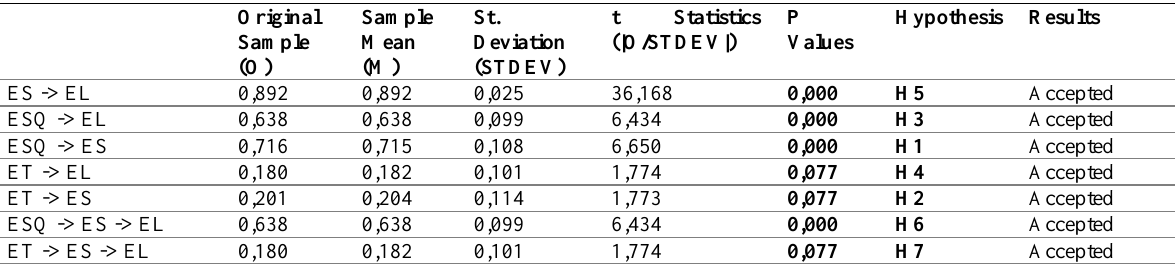
Table 3: Hypothesis Testing